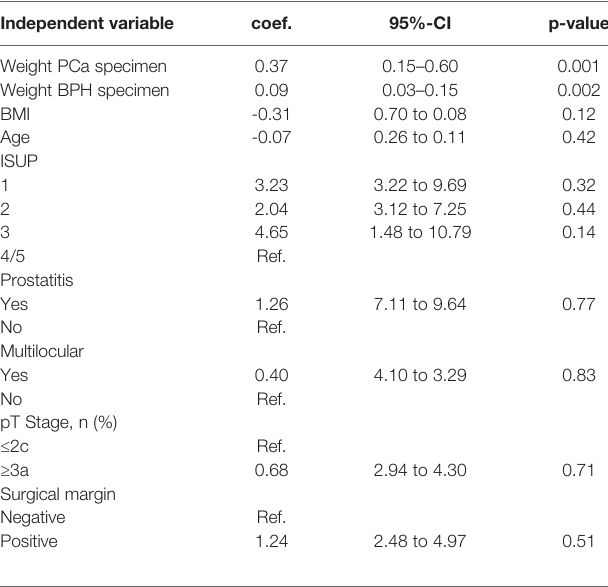
TABLE 3 | Multivariable linear regression analysis correlating preoperative PSA (ng/ml) as a dependent variable with selected independent variables. Independent variable